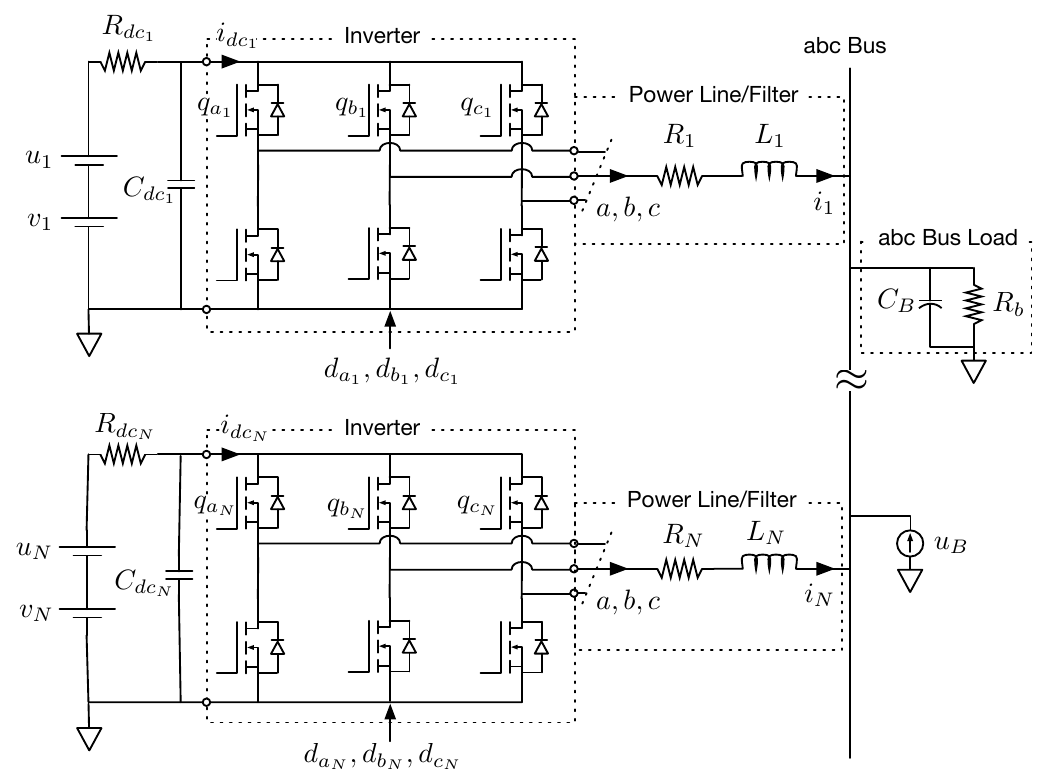
Figure 1. Schematic of an N -inverter system in the abc